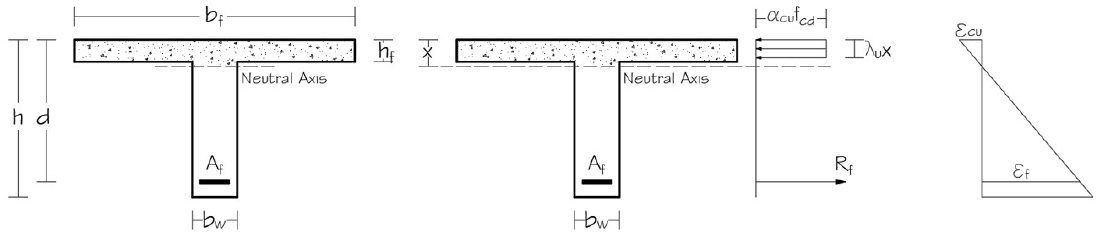
Figure 8. Equilibrium and compatibility of a compression-controlled section with stress block on the flange [8].